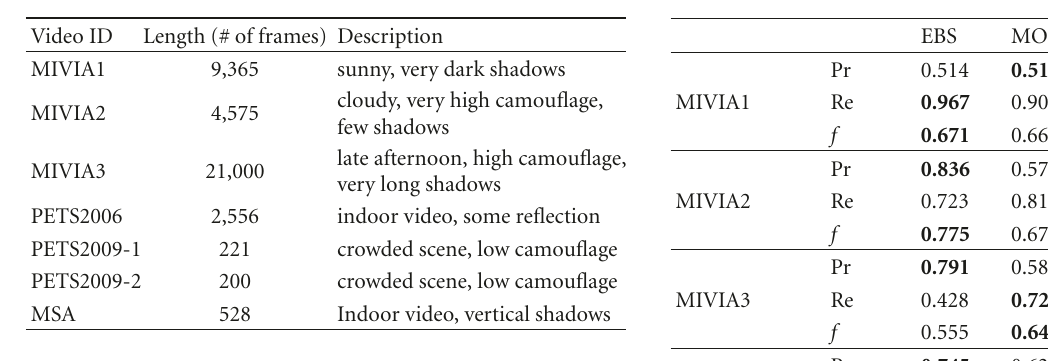
Table 1: Characteristics of the employed dataset. videos were acquired at 25 FPS.